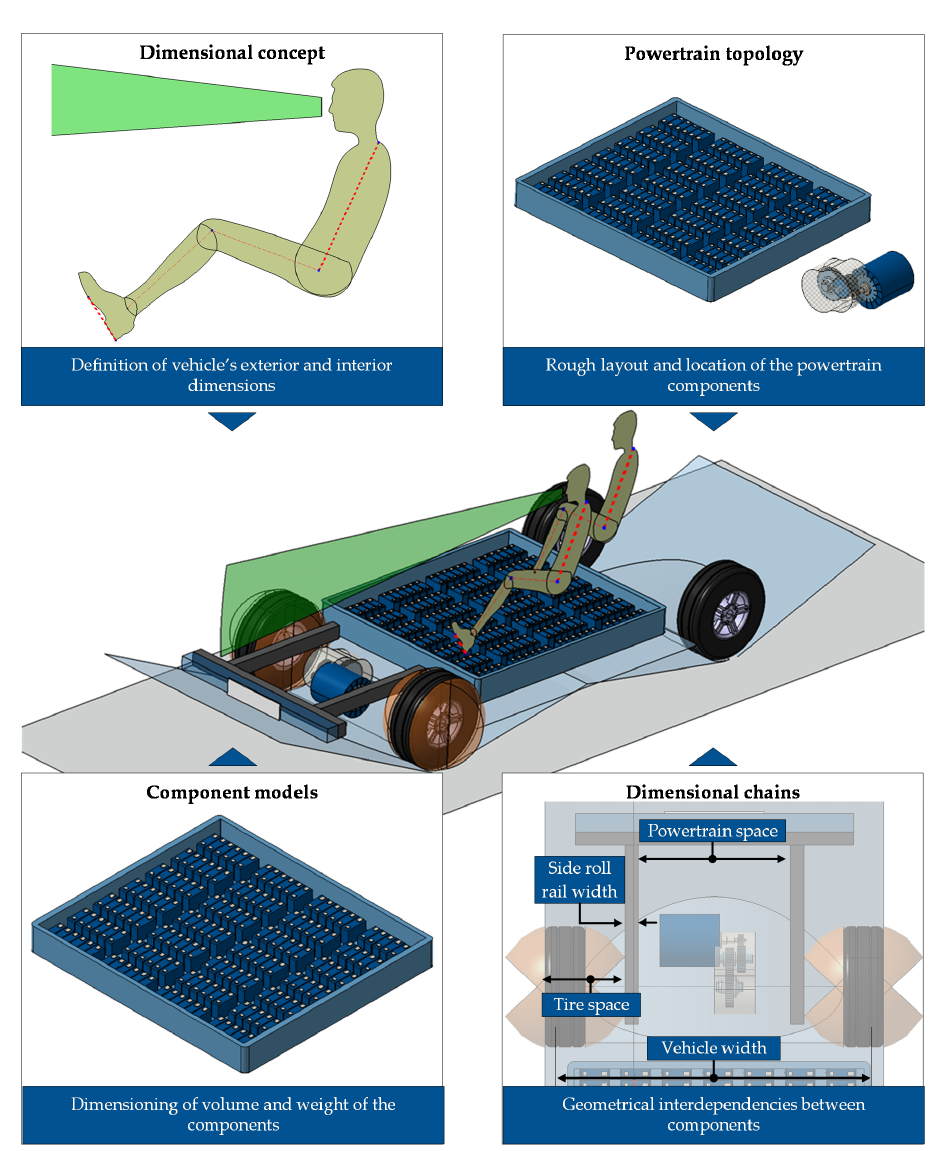
Figure 2. Overview of the architectural features, based on [4.]